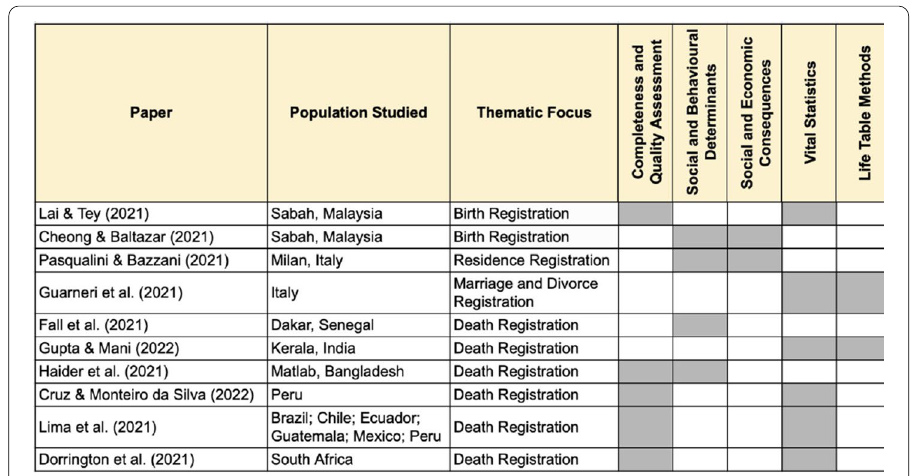
Fig. 3 Methodological approaches employed by papers in the Genus thematic series on civil registration and vital statistics